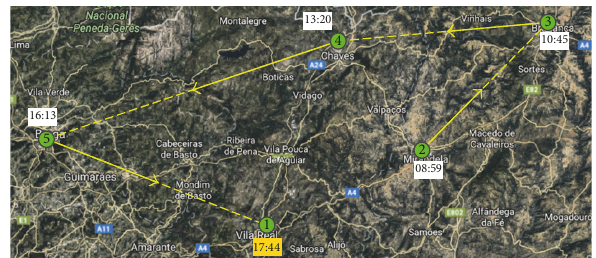
Figure 5: Routing and scheduling solution provided by the higher operational layer due to a predicted delay greater than the